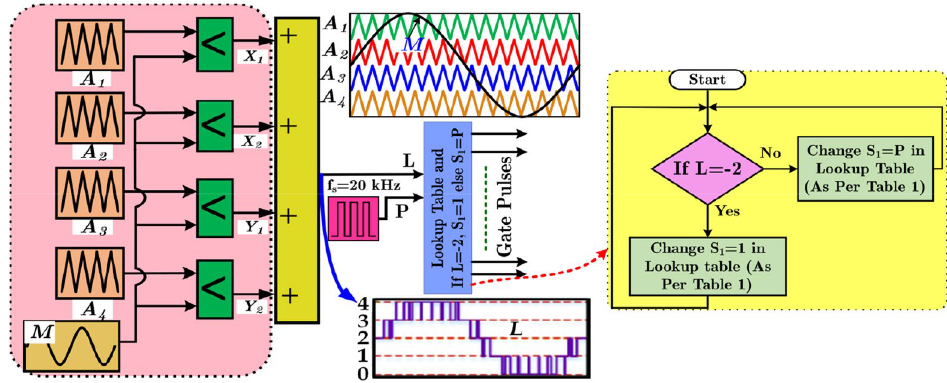
Figure 4. Proposed PWM scheme.